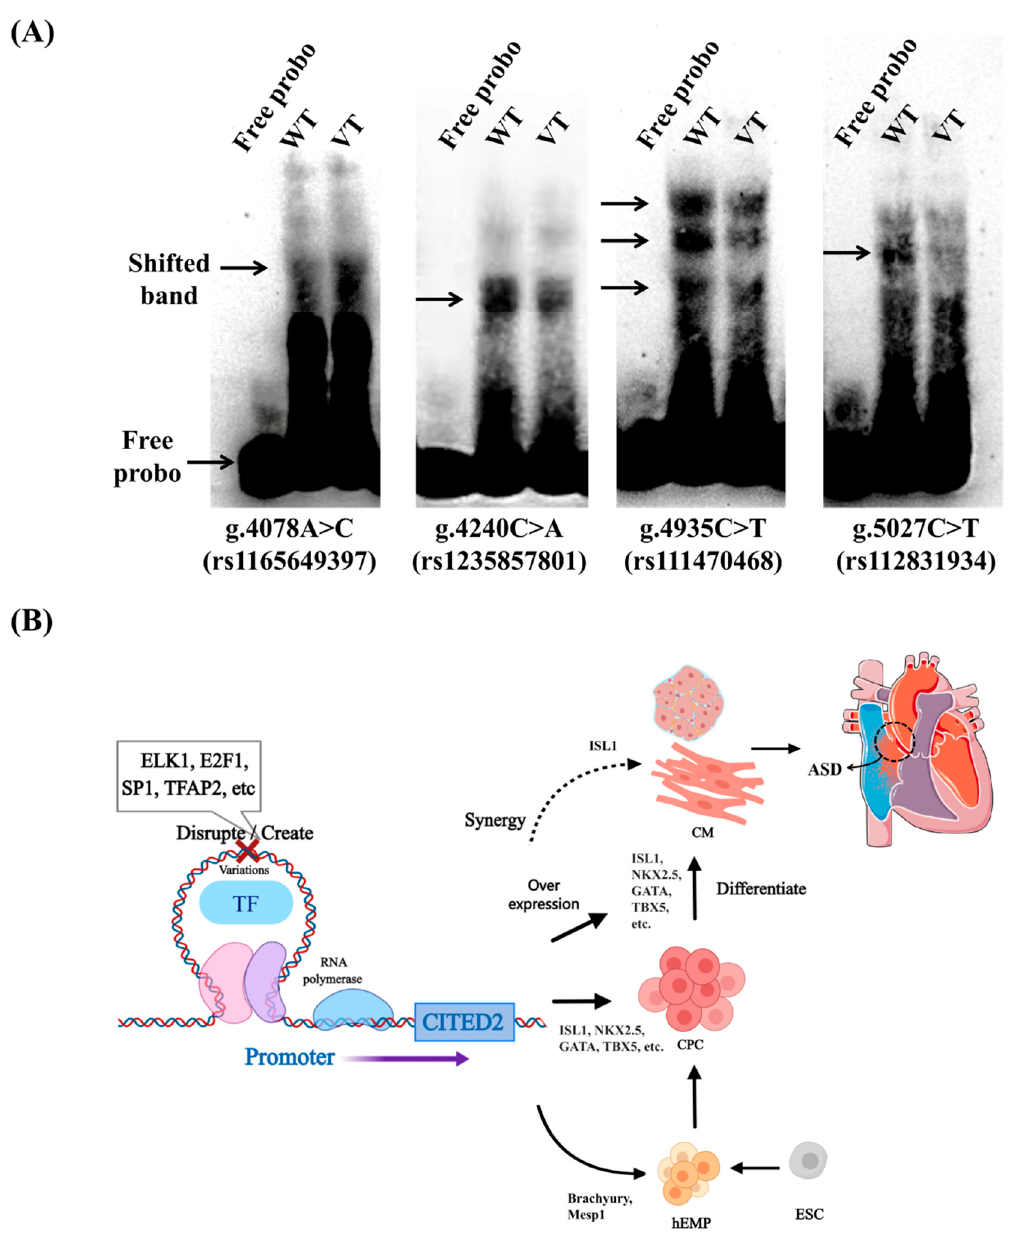
Figure 4. Electrophoretic mobility shift analysis (EMSA) experiments and schema for effect of variants in the CITED2 promoter region on possible pathways in cardiac development. ( A ) Results of EMSA of CITED2 gene promoter variants. The results show that the variants (g.4078A>C(rs1165649373), g.4240C>A(rs1235857801), g.4935C>T(rs111470468), g.5027C>T(rs112831934)) significantly affected transcription factor binding capacity. Free probes are marked on the bottom; arrows indicate affected binding of unknown transcription factors; WT, wild type; VT, variant. ( B ) Effect of variants in the CITED2 promoter region on some transcription factors and the possible consequence in cardiac development. CM, mature cardiomyocytes; CPC, Cardiac progenitor cells; hEMP, mesoderm progenitor cells; ESC, embryonic stem cells.